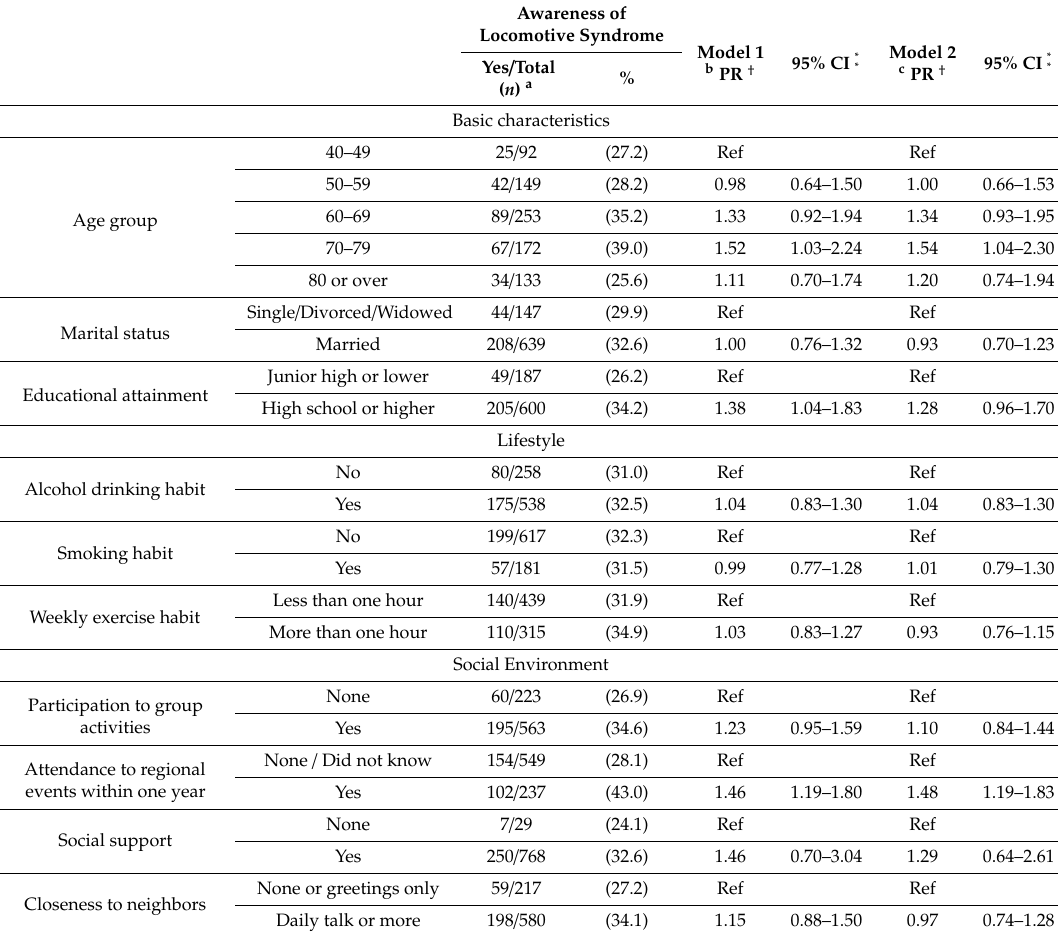
Table 3. Adjusted prevalence ratios of each covariates to increase awareness of locomotive syndrome in